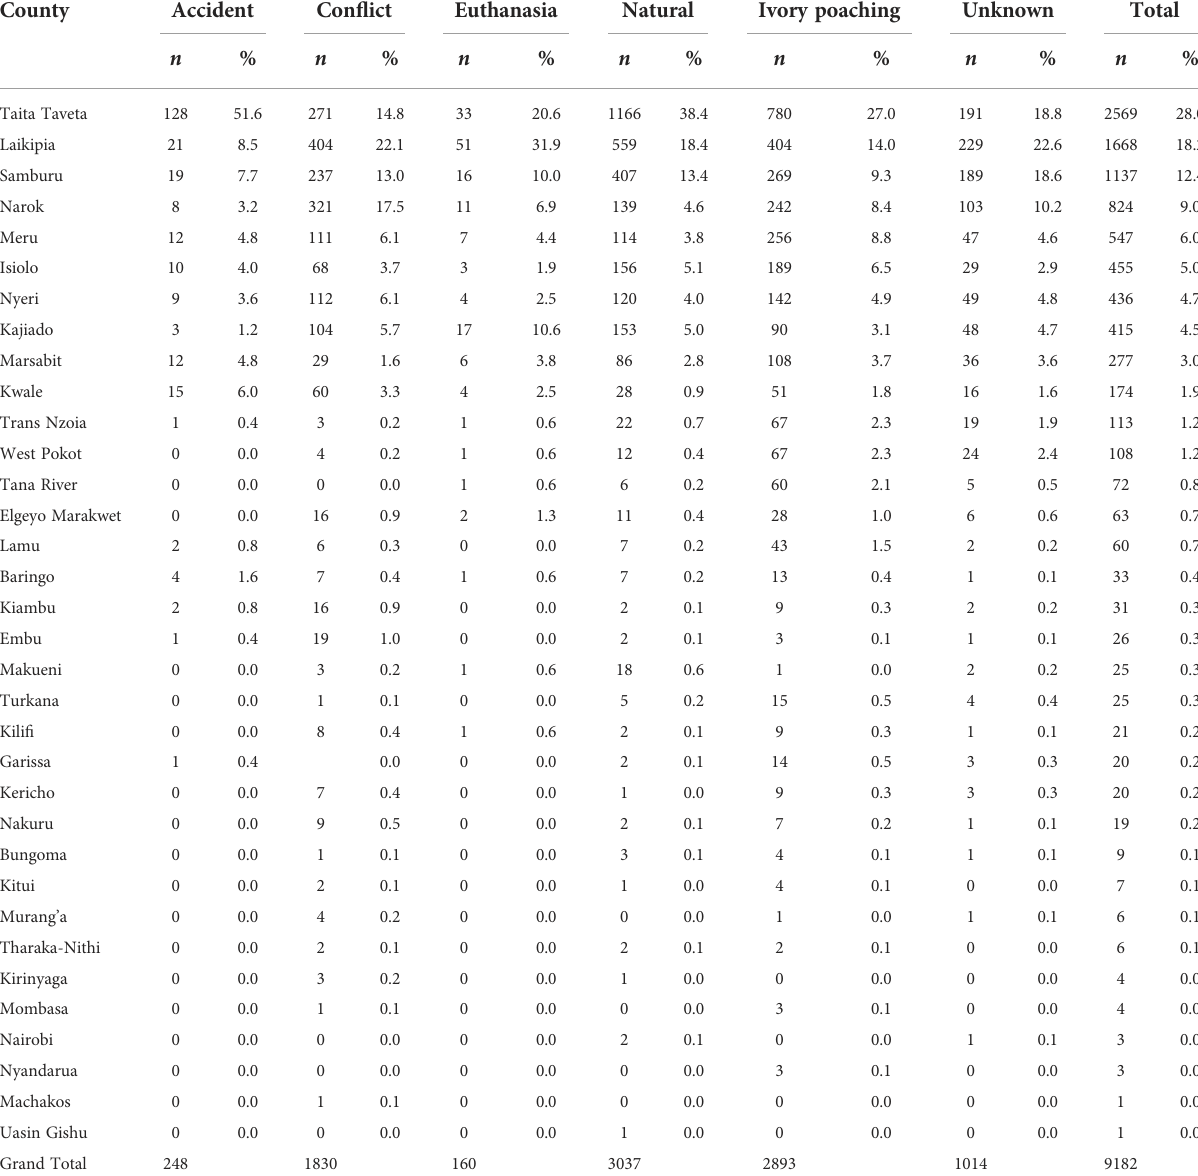
TABLE 2 Total elephant mortality by county and cause in Kenya during 1992 – 2017.